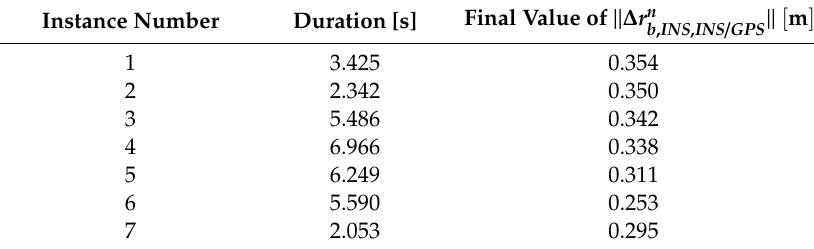
Table 1. MINS results for flight no